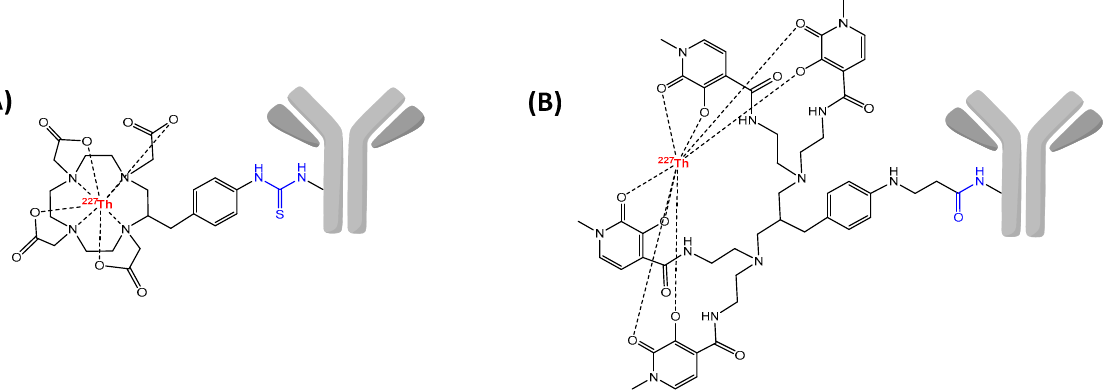
Figure 10. Schematic representation of 227 Th-labeled radioimmunoconjugates based on p -SCN-Bn-DOTA ( A ) or Me-3,2- HOPO ( B ).